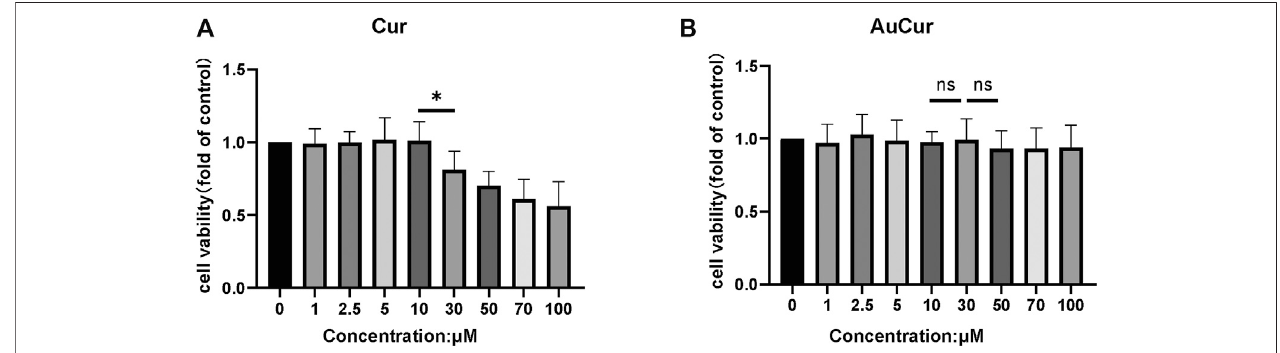
FIGURE2| CellviabilityanalysisofCurandAuCur. (A) TheMTTofH9C2cellsfor24 hwastreatedwithCur. (B) MTTofH9C2cellsfor24 hwastreatedwithAuCur. * p < 0.05. ns: Not Statistically Signi fi cant. Cur: curcumin, AuCur: Curcumin-AuNCs.